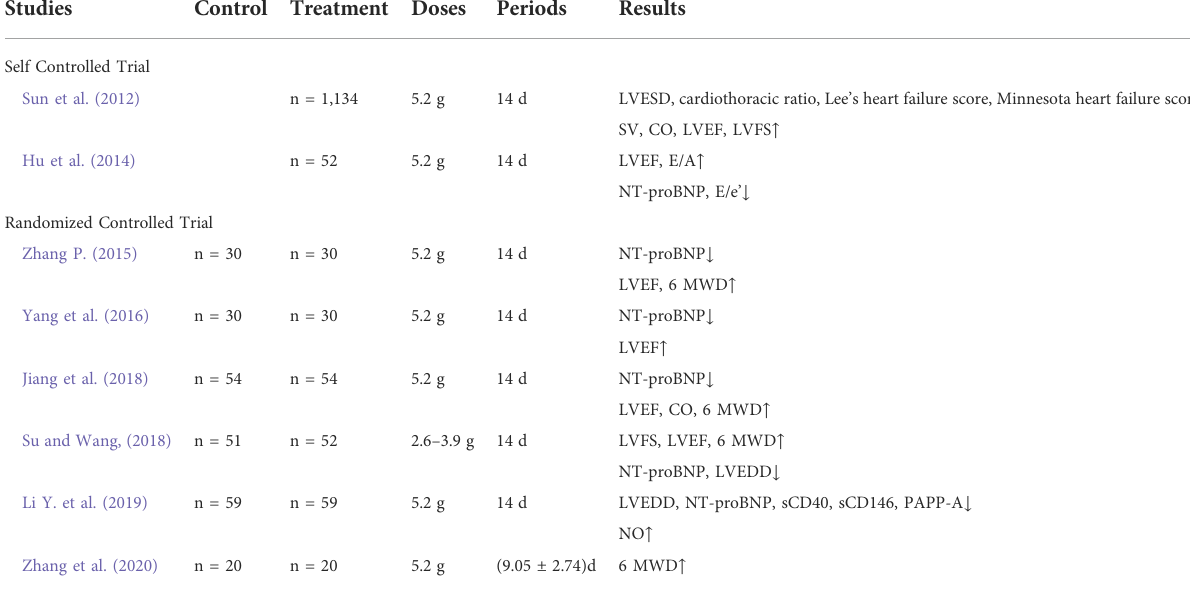
TABLE 3 Clinical trials of YiQiFuMai injection in the treatment of heart failure.